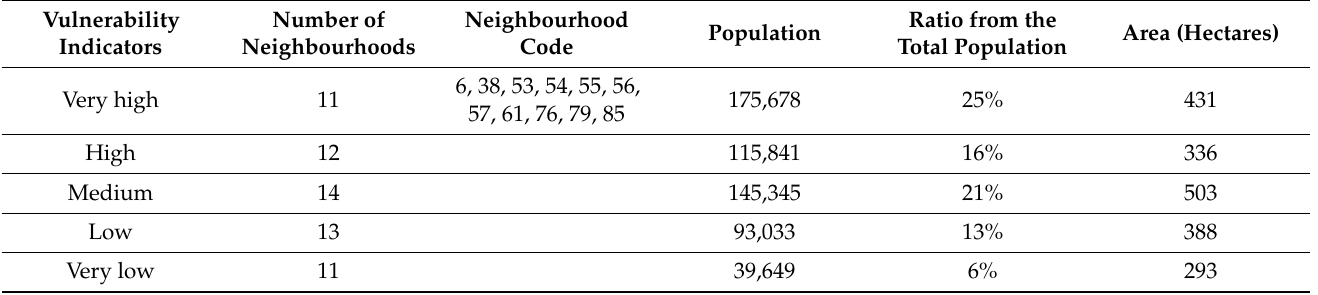
Table 8. First classification scenario of city neighbourhoods based on the comprehensive vulnerability index (Vt).